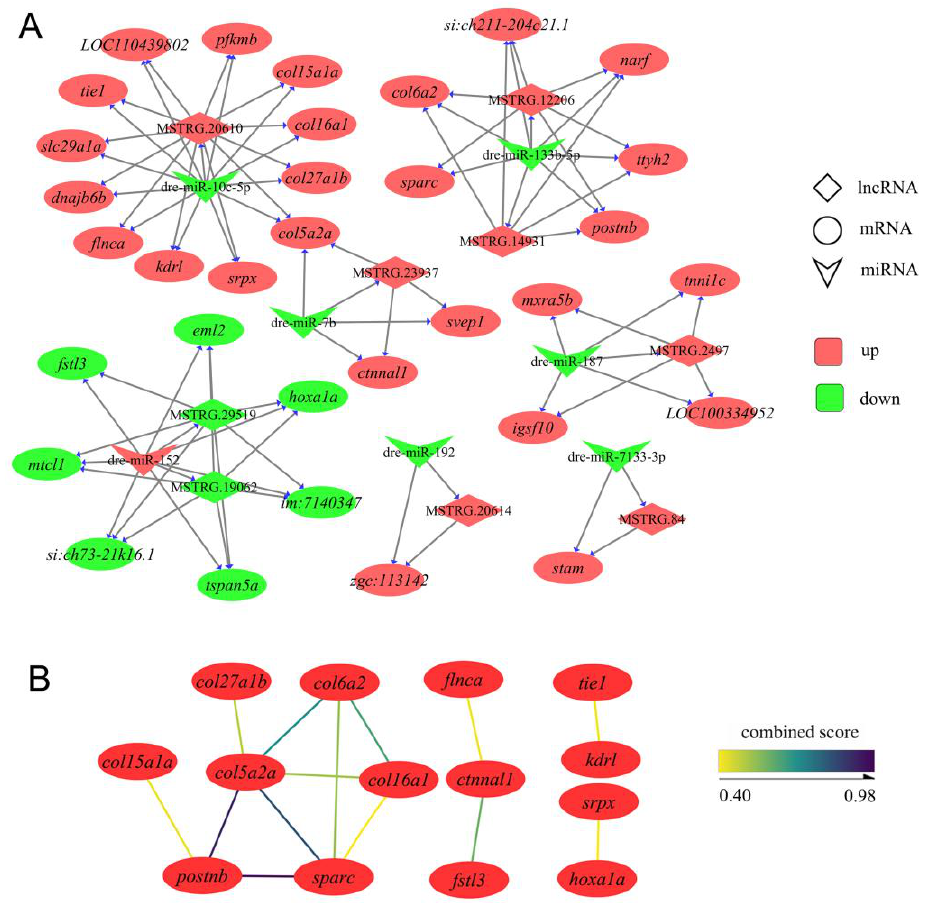
Figure 4. The details of ceRNA networks associated with the development of IBs. ( A ) The ceRNA networks are associated with IB development. Red represents upregulation, and the green represents downregulation. ( B ) Protein interactions are present in the ceRNA networks.